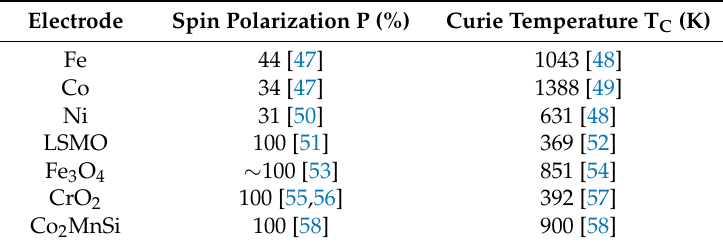
Table 1. Representative FM materials used as OSV electrodes.